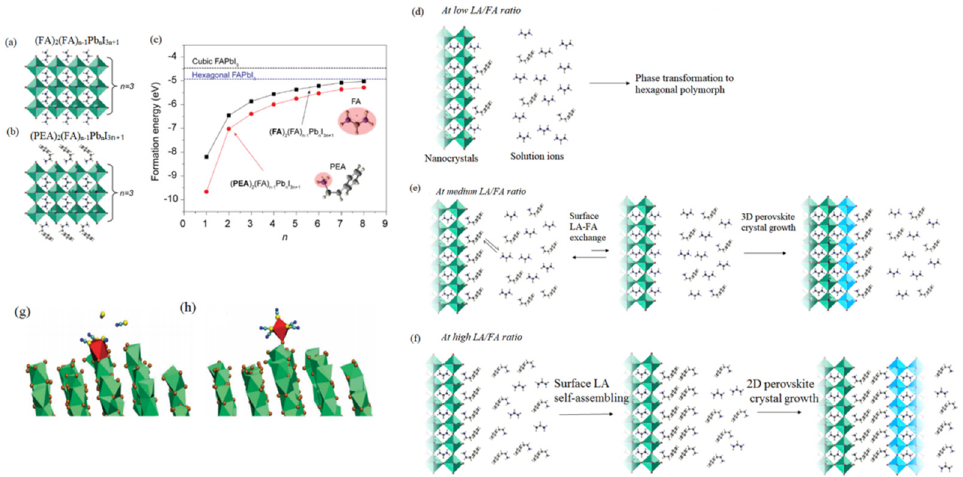
Figure 6. Structures of the ( a ) (FA) 2 (FA) n − 1 Pb n I 3n+1 and ( b ) (PEA) 2 (FA) n − 1 Pb n I 3n+1 ; and ( c ) Corresponding the calculated formation energies. The growth processes with different α ratios. ( d ) the hexagonal phase perovskite was formed at a low α value; ( e ) A new 3D cubic perovskite was formed at a proper α value; ( f ) layered perovskites were formed by self-assembly at a high α value. (Reprinted with permission from Ref. [90]. Copyright 2017 ACS Publications). MD simulations displayed the initial face-sharing octahedra ( g ) conversion into the corner-sharing octahedra ( h ). Pb-I (green); iodideis (orange balls); octahedra (red); S (yellow); C (light blue); N (dark blue). Reprinted with permission from Ref. [91]. Copyright 2020 Science.